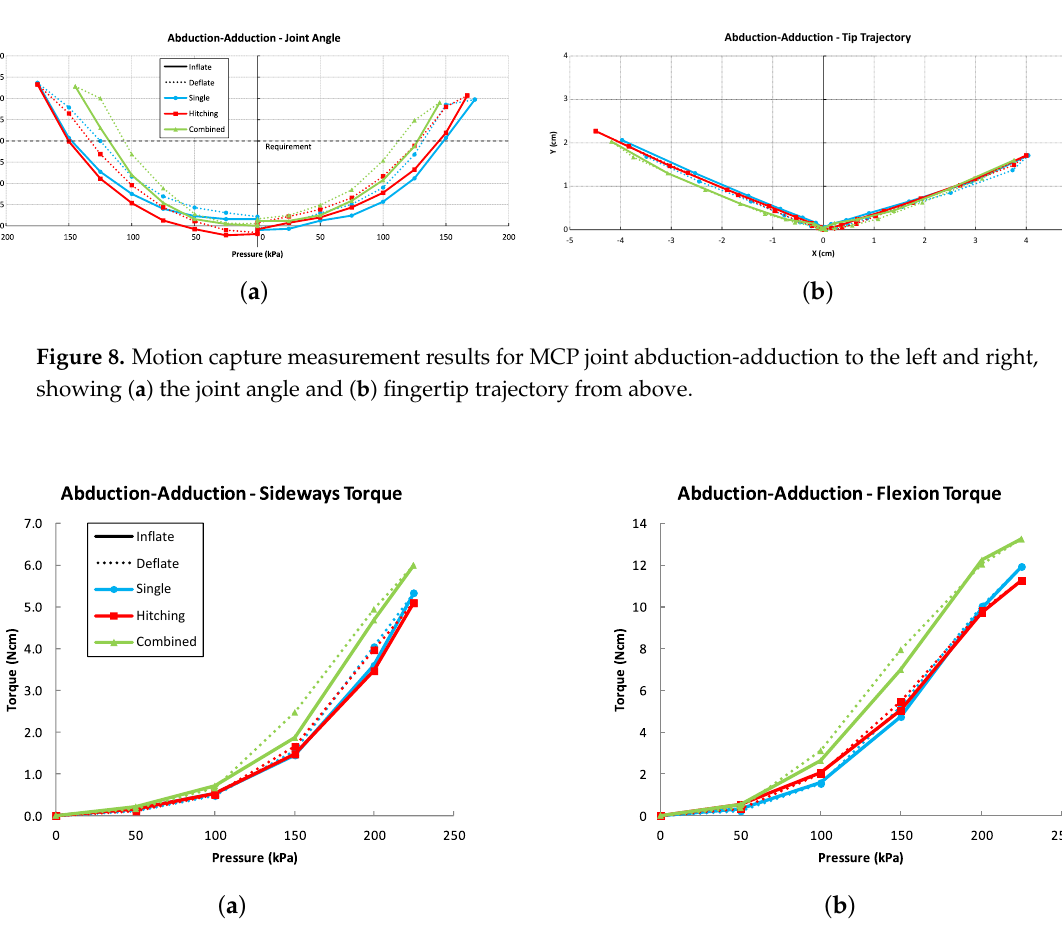
Figure 9. Torque measurement results for MCP joint abduction-adduction in ( a ) sideways and ( b ) flexion directions. The result is the average of measurements to the left and to the right. Note that the scale for flexion torque is double that of